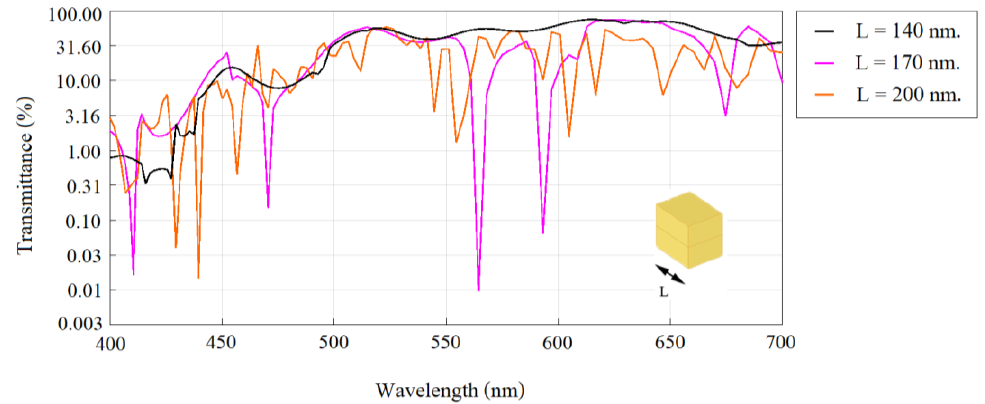
Figure 5. Transmittance when W is varied from 110 to 200 nm.